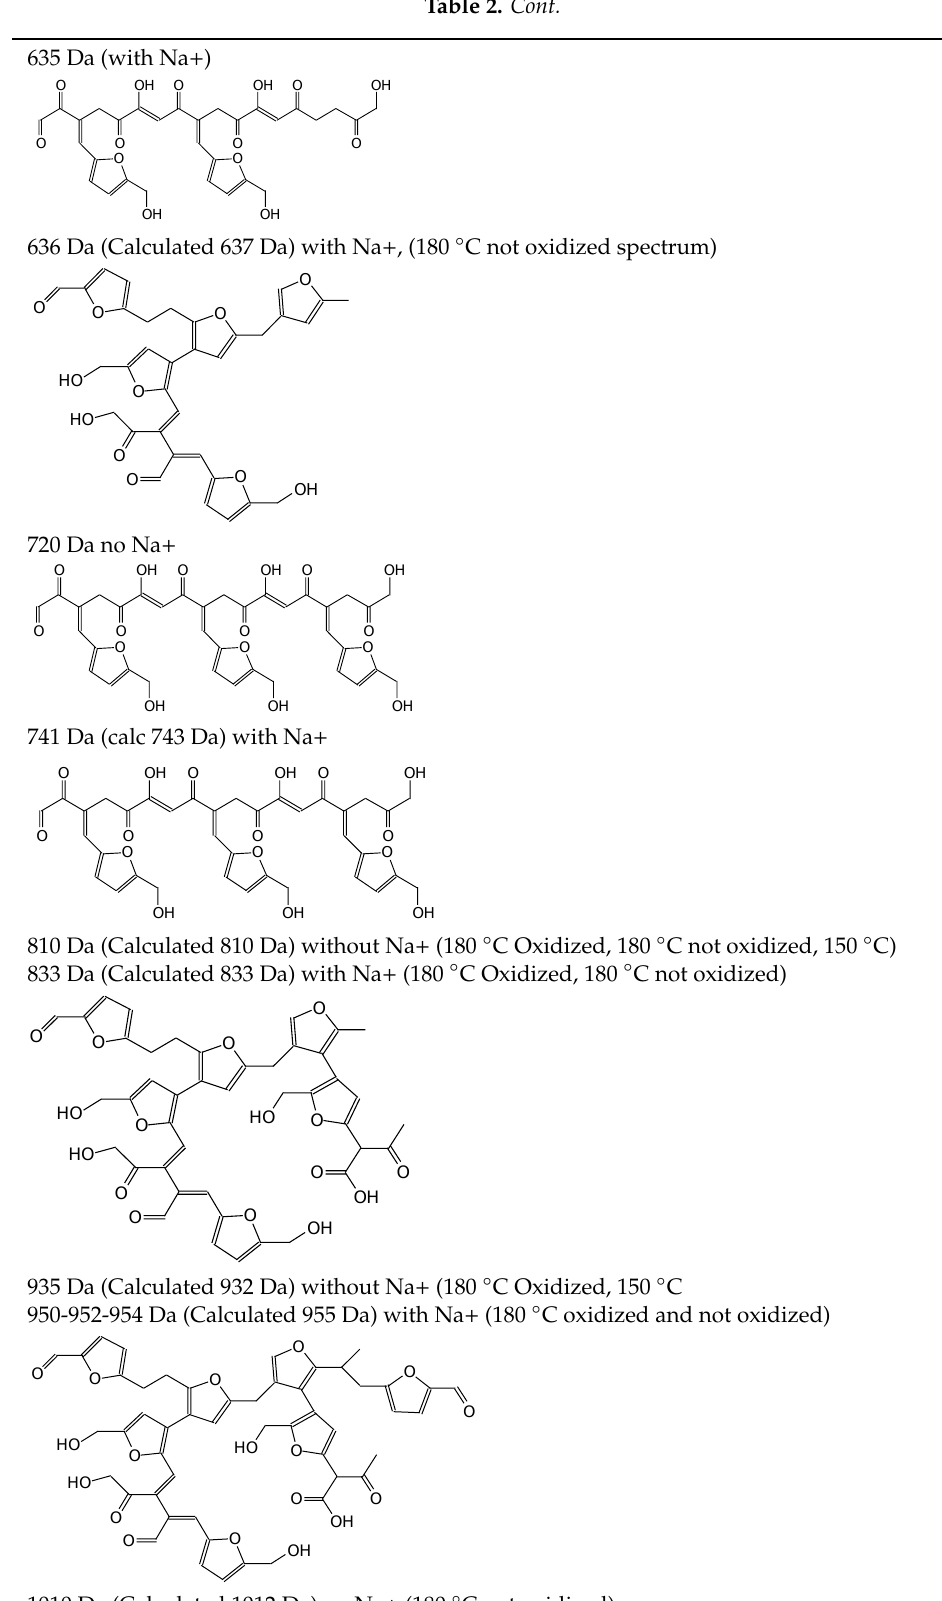
O O O OO OO OO OO OO OO H H H H H H 636 Da (Calculated 637 Da) with Na+, (180 °C not oxidized spectrum) 636 Da (Calculated 637 Da) with Na+, (180 °C not oxidized spectrum) 636 Da (Calculated 637 Da) with Na+, (180 °C not oxidized spectrum) O O O OO O OO O OO O